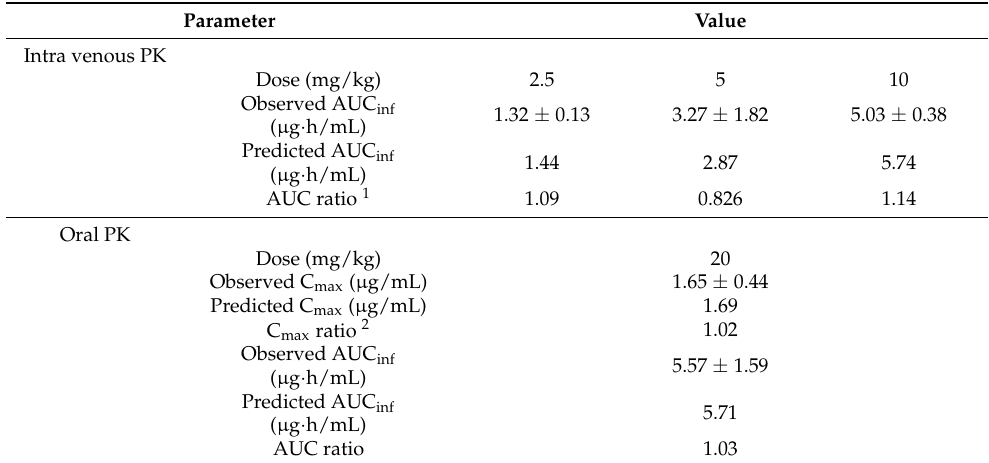
Table 3. Observed and predicted PK parameters of IDP-73152 in